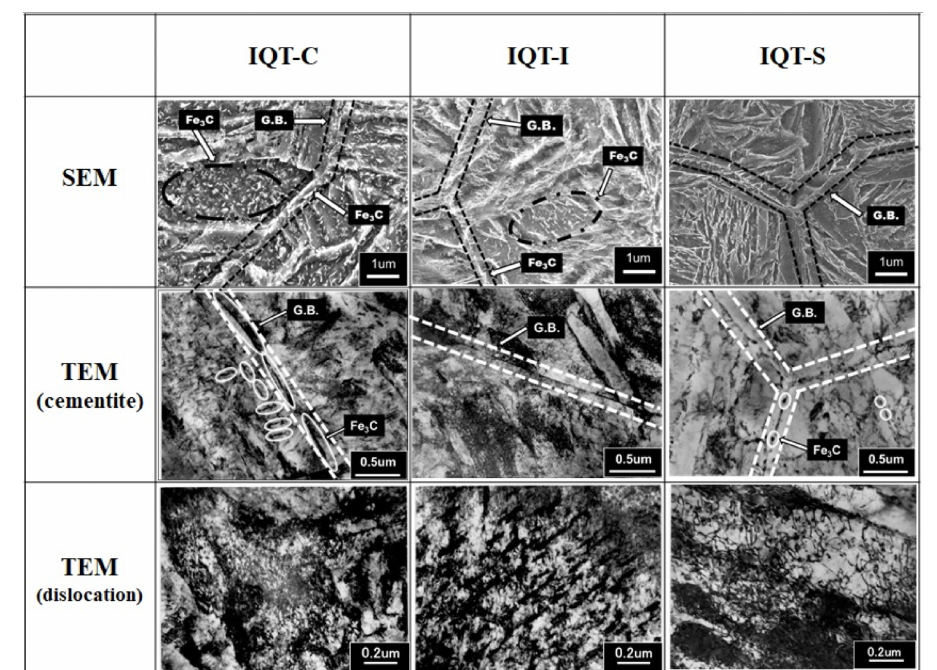
Figure 17. Microstructures of specimens obtained by a scanning electron microscopy and a transmission electron microscopy. The micrographs of IQT-S specimen are observed in surface-softened area at 0.4 mm apart from the surface.